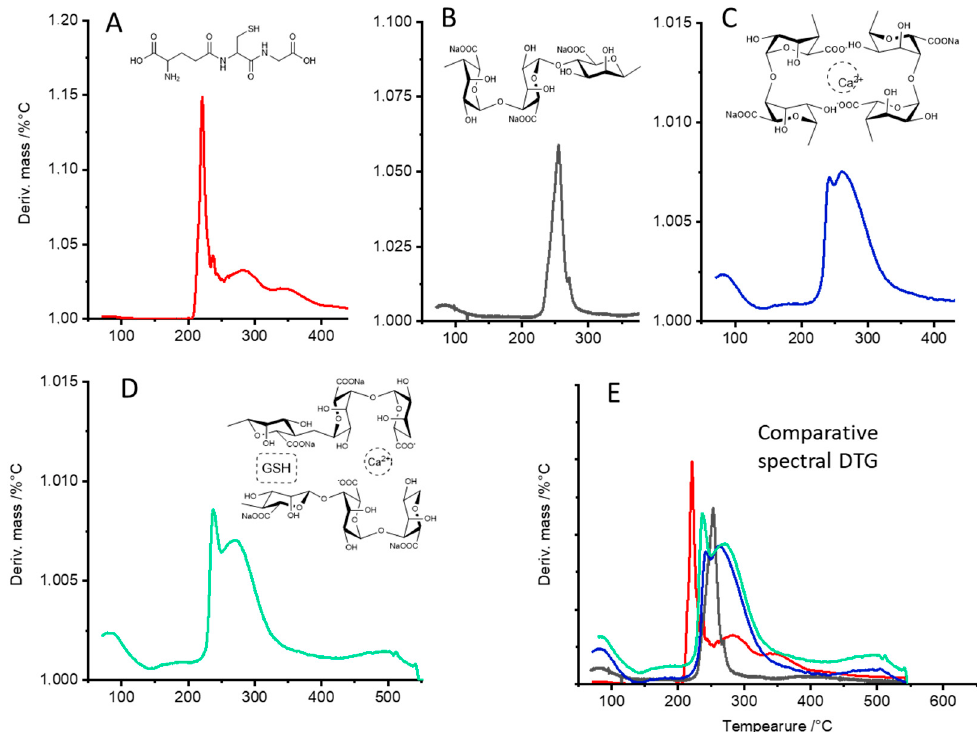
Figure 5. DTG curves; ( A ) glutathione, ( B ) Na-alginate, ( C ) Ca-alginate, ( D ) complex Ca-alginate-GSH, and ( E ) comparative image of overlapped curves.